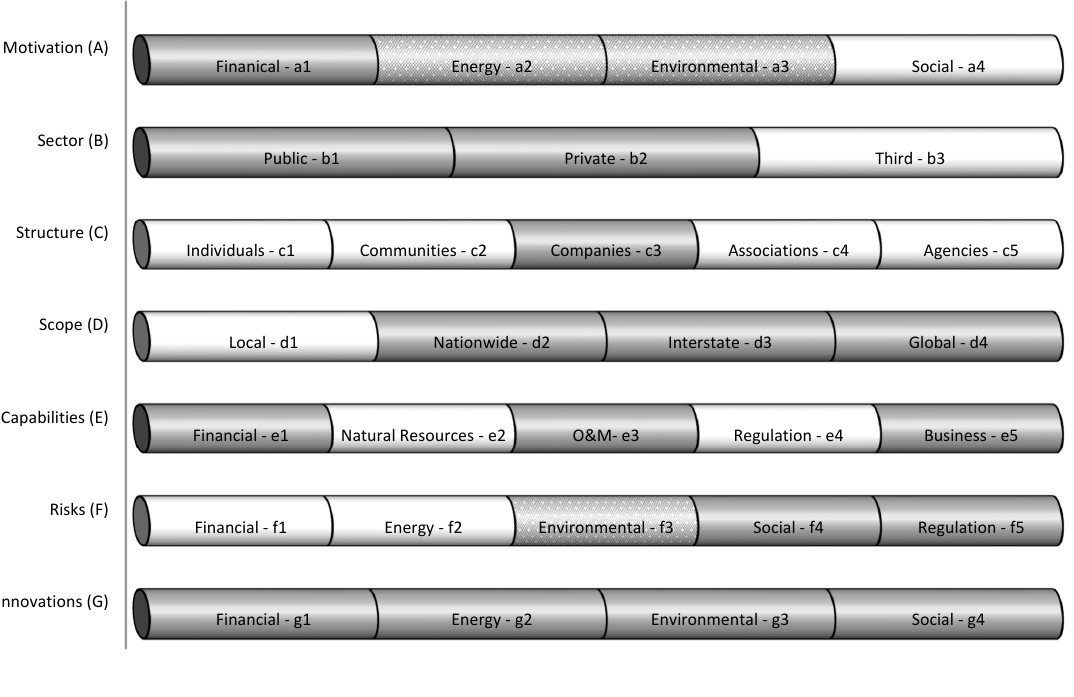
Figure 4. Schematic profile of Ørsted.